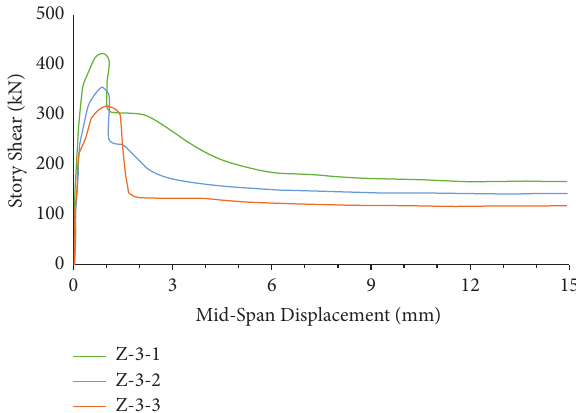
Figure 20: Diagram of story shear versus midspan displacement for models with different opening area under loading in Z Table 7: Obtained parameters and results from models with opening with different areas under loading in X direction. Deterioration of